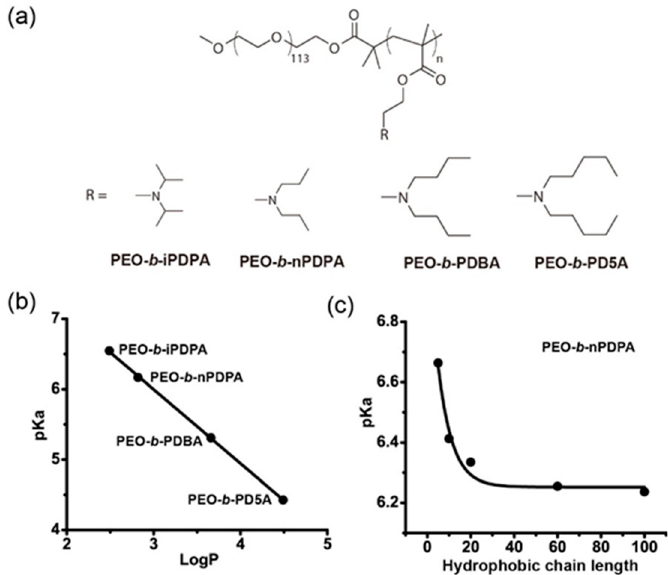
Figure 7. Tunable pKa based on hydrophobic modification. ( a ) Structure of methacrylate-based block copolymers with different alkyl substituents. ( b ) Increase of the hydrophobicity of the alkyl substituents resulted in the linear decrease of pKa. ( c ) Increased hydrophobic chain length lead to decreased pKa in a representative poly(ethylene glycol)- b -poly(2-(diisopropylamino)ethyl methacrylate) (PEG- b -PDPA) polymer. Reproduced with permission from Yang Li, Zhaohui Wang, Qi Wei, Min Luo, Gang Huang, Baran D. Sumer, and Jinming Gao. Biomaterials; published by Elsevier,